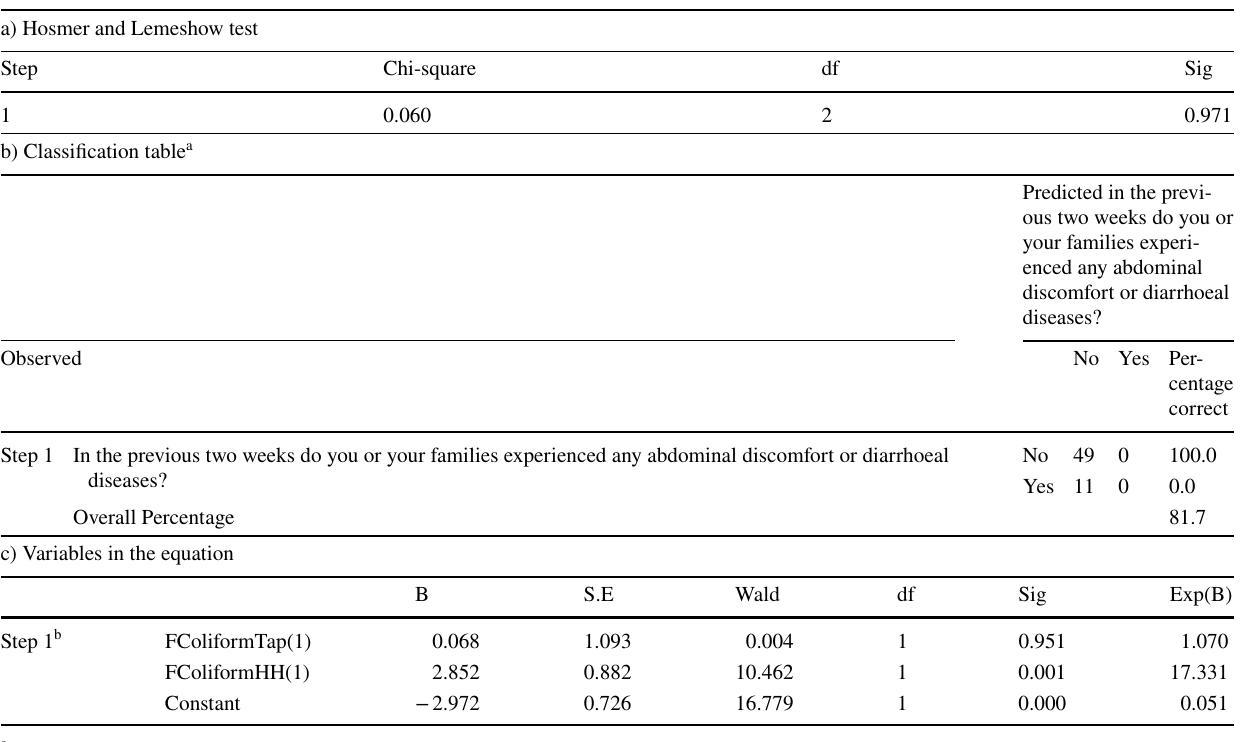
Table 5 Binary Logistic Regression result for detection of faecal coliform in water samples and occurrence of diarrhoeal diseases,